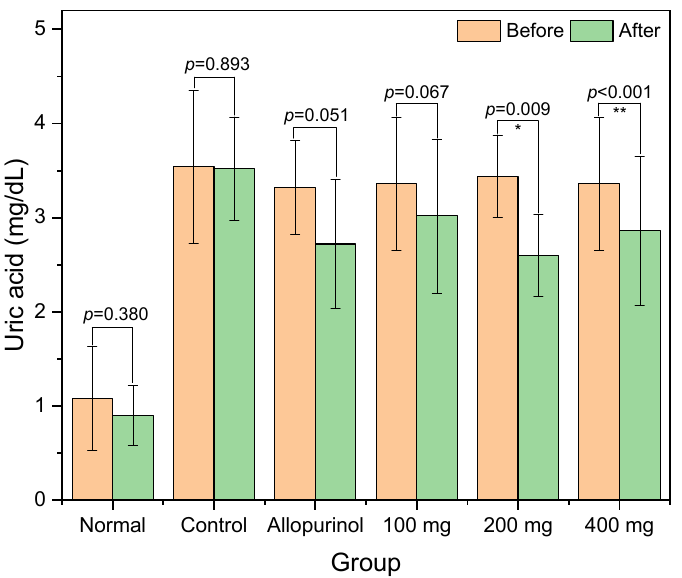
Figure 2. Serum uric acid levels in the hyperuricemic rats before and after the intervention. * Statis- tically significant at p < 0.01 and ** very significant at p < 0.01 based on paired t -test.